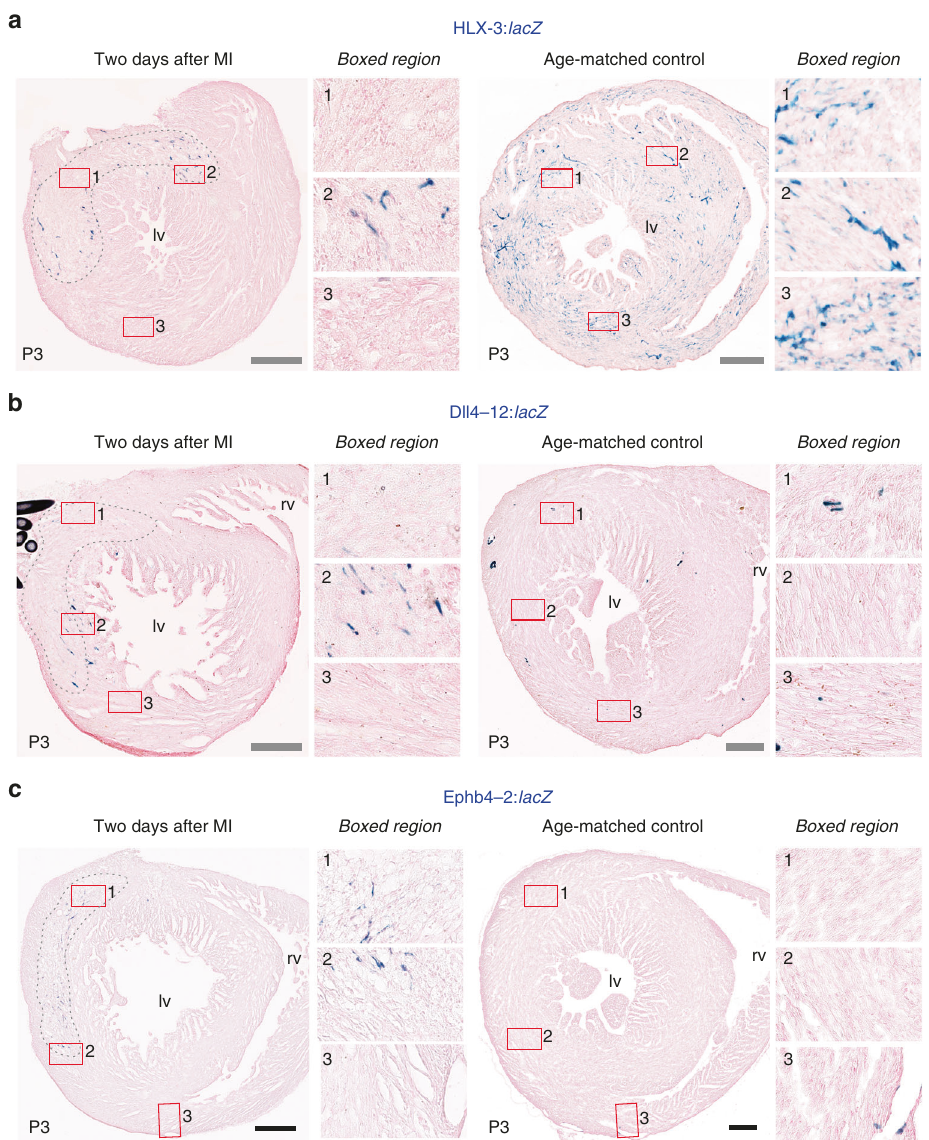
Fig. 8 Developmental vascular regulatory pathways are reactivated during neovascularisation in the regenerative P1 neonatal heart after MI. a – c Permanent ligation of the left anterior descending coronary artery was performed on transgenic neonatal hearts to mimic MI. Representative sections through P3 HLX- 3: lacZ ( a , n = 6 biologically independent animals), Dll4-12: lacZ ( b , n = 5 biologically independent animals) and Ephb4-2: lacZ ( c , n = 4 biologically independent animals) transgenic hearts collected two days after MI surgery show enhancer activity in ECs surrounding the injured tissue. Dashed grey lines indicate the injured myocardium, and boxed regions show magni fi ed views within the injury (box 1), at the injury border zone (box 2) and at a remote region (box 3). Sections through age-matched control hearts are shown alongside, with comparable boxed regions selected for the magni fi ed views. lv, left ventricle; rv, right ventricle. Grey scale bars represent 200 µ